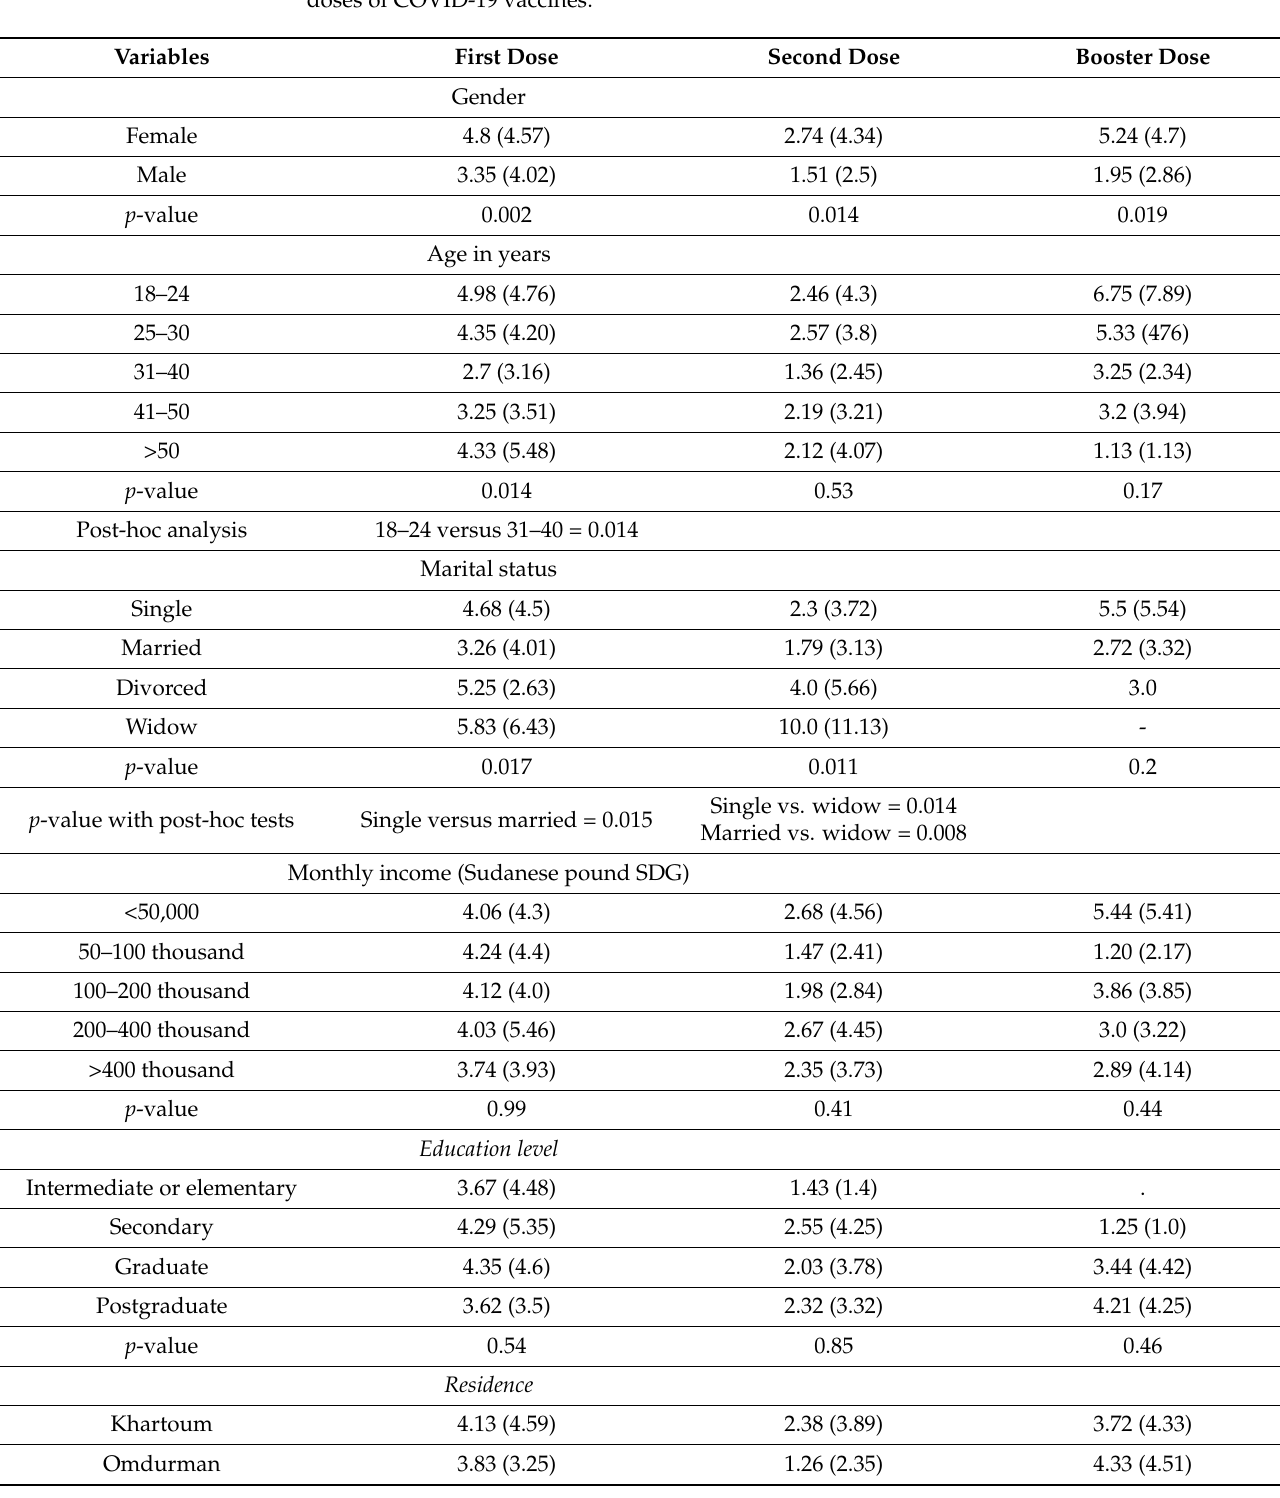
Table 8. Distribution of side-effect score among demographic features after primary and booster doses of COVID-19